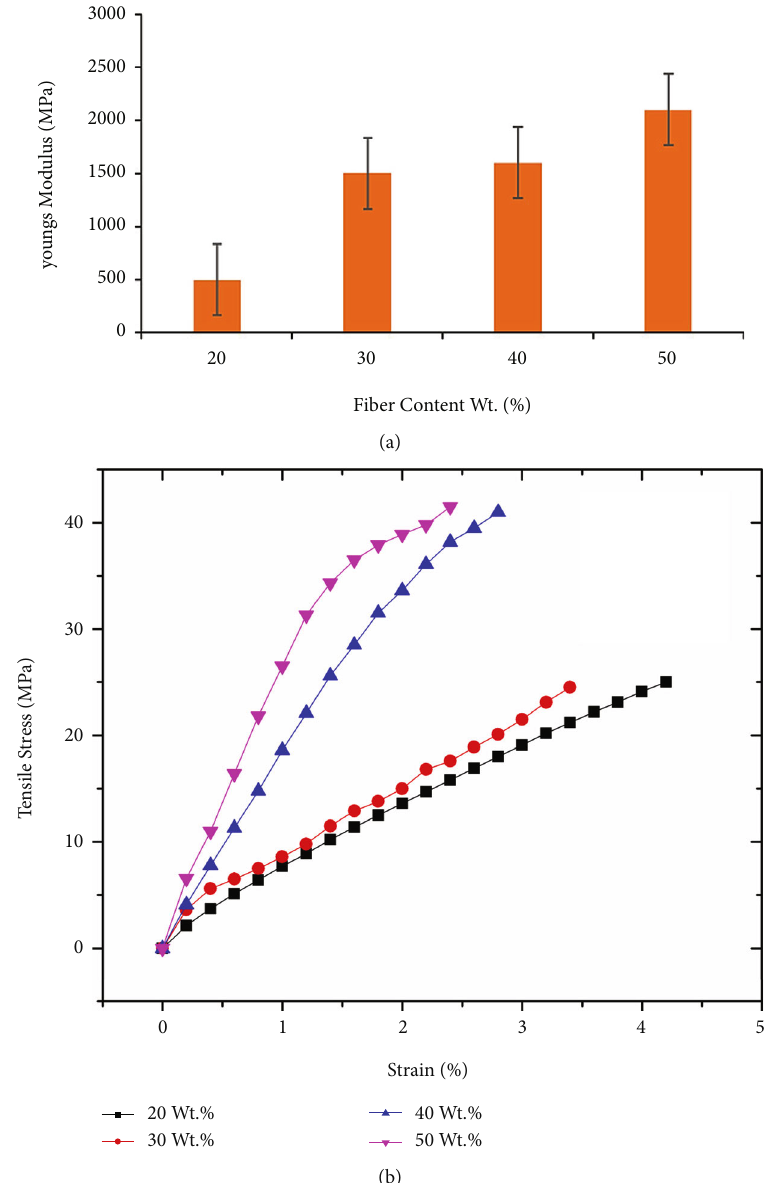
Figure 5: (a) Youngs modulus vs. fi ber content. (b) Stress (tensile) vs. strain graph for di ff erent wt% of areca nut fi